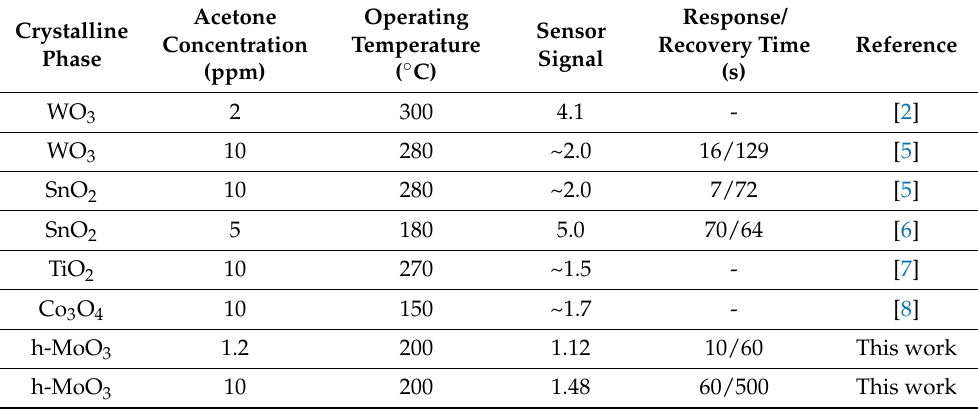
Figure 3. ( a ) Transient acetone sensing response and ( b ) steady-state resistance and sensor signal of the h-MoO 3 sensor (sensor 1) as a function of the concentration at 200 °C. Table 1. Acetone sensing performance of selected